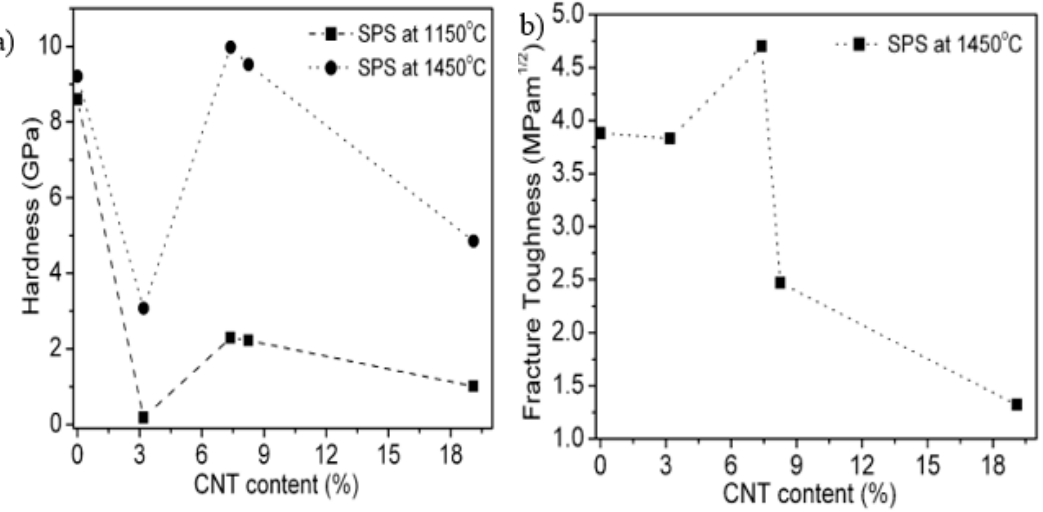
Figure 3. Mechanical hardness ( a ) and fracture toughness ( b ) variation with carbon nanotube (CNT) content. Reproduced with permission from [111]. Copyright Elsevier, 2009. Table 2. Mechanical properties of Alumina-CNT nanocomposites.